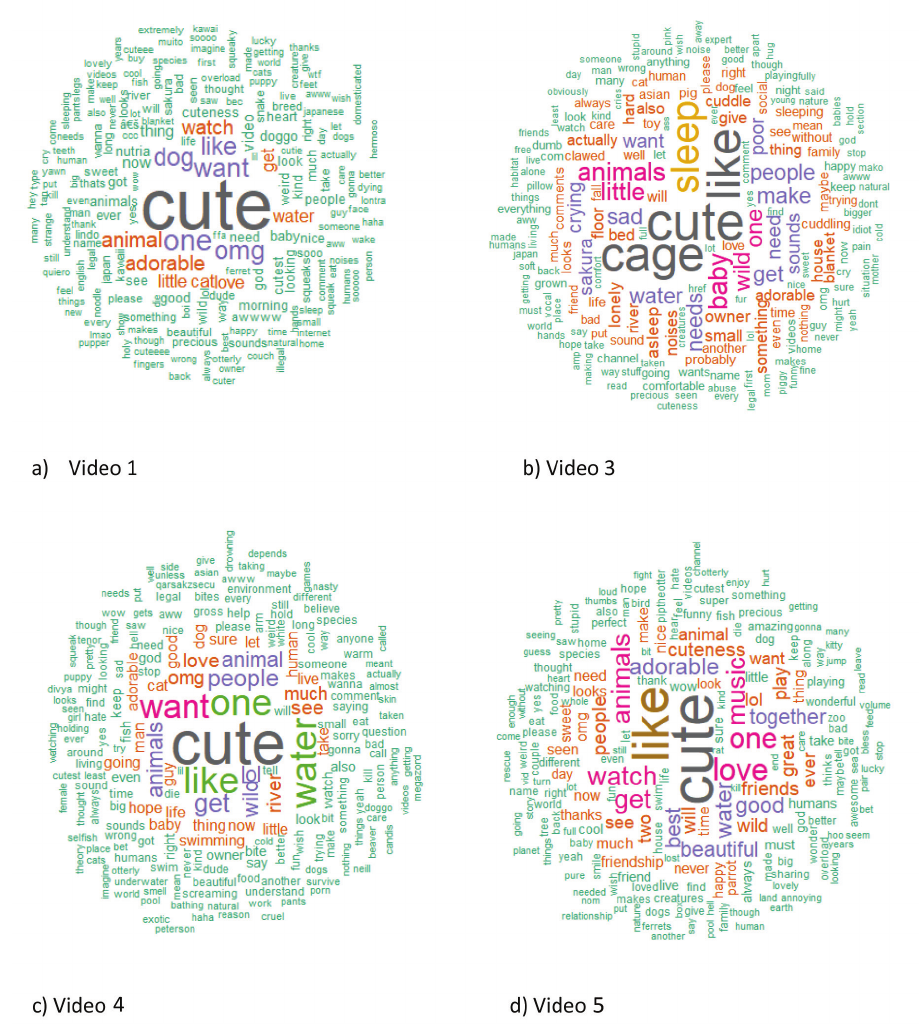
Figure A4. Wordclouds depicting the nature of comments for four pet otter influencer videos (Videos 1, 3, 4, and 5 in Table 2). “Influencer video’ defined as the most viewed and most popular videos with > median views, and > median like:view ratios. Font size is relative to the frequency at which each of the words appears in the comments; stopwords and profanities have been removed (see